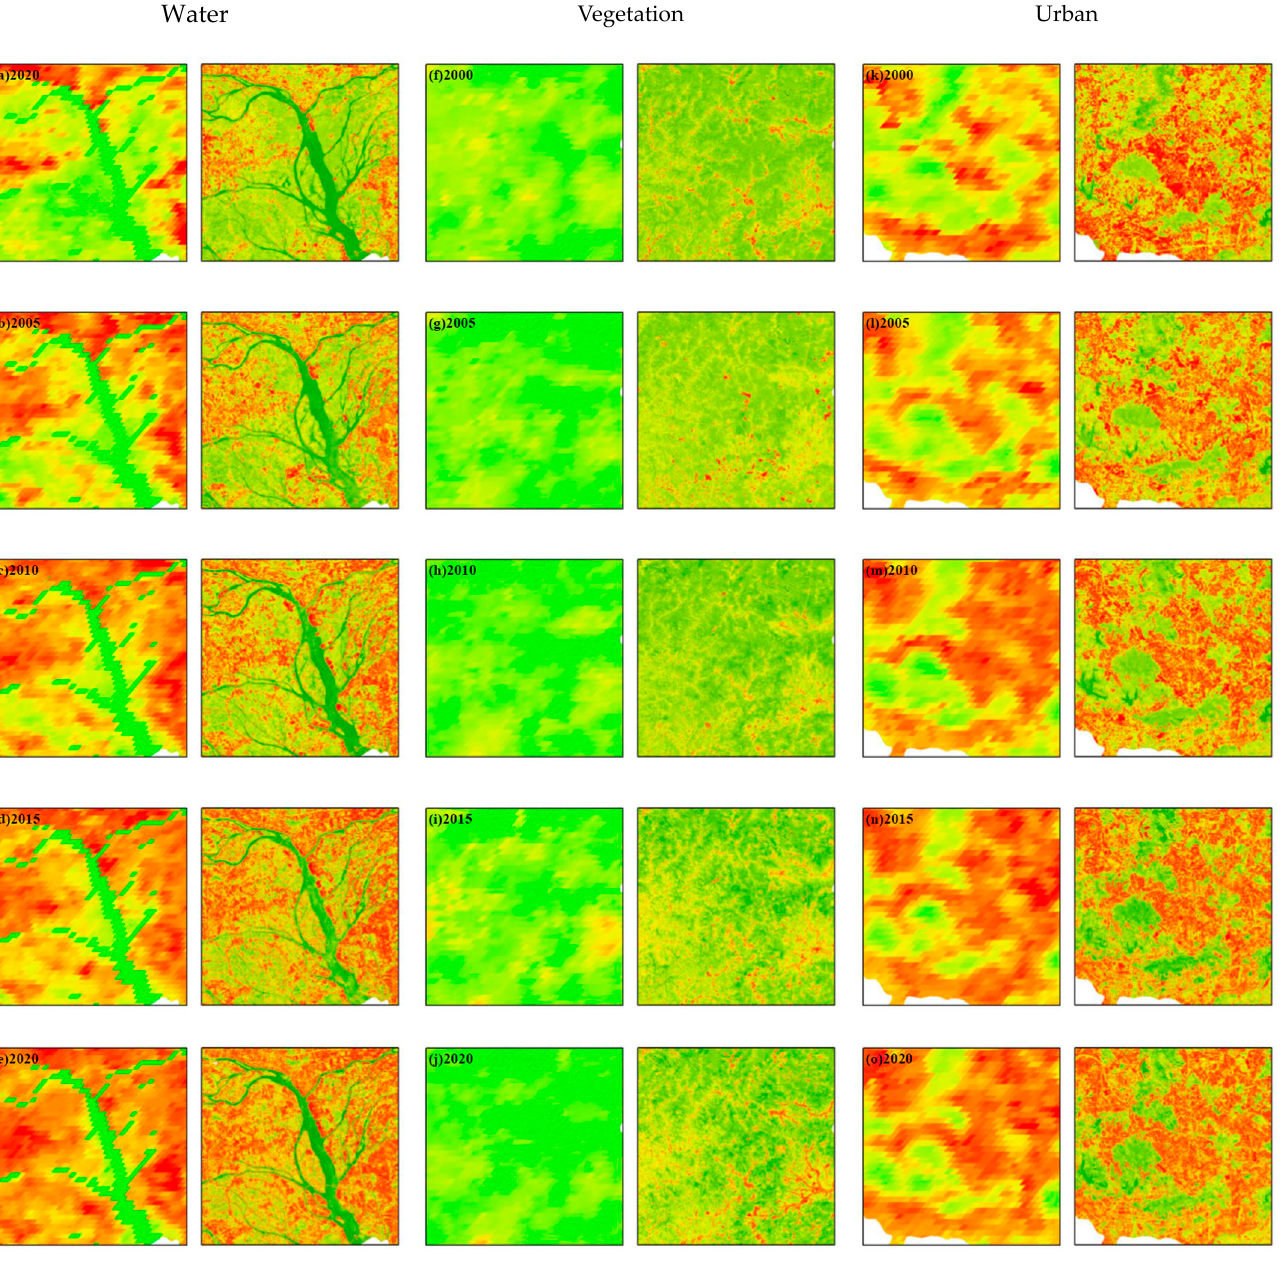
Figure 3. MODIS LST downscaling effect of different land cover regions (water, vegetation, and